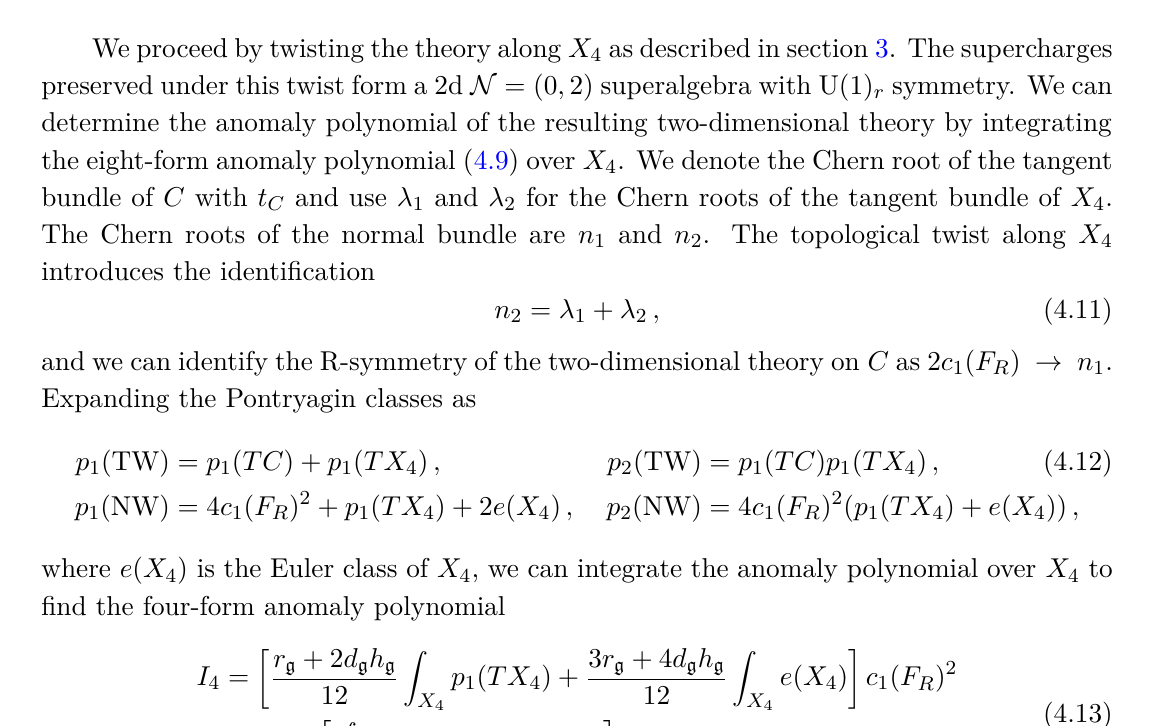
Table 3 . Rank, dimension and Coxeter number of the Lie algebras of type g